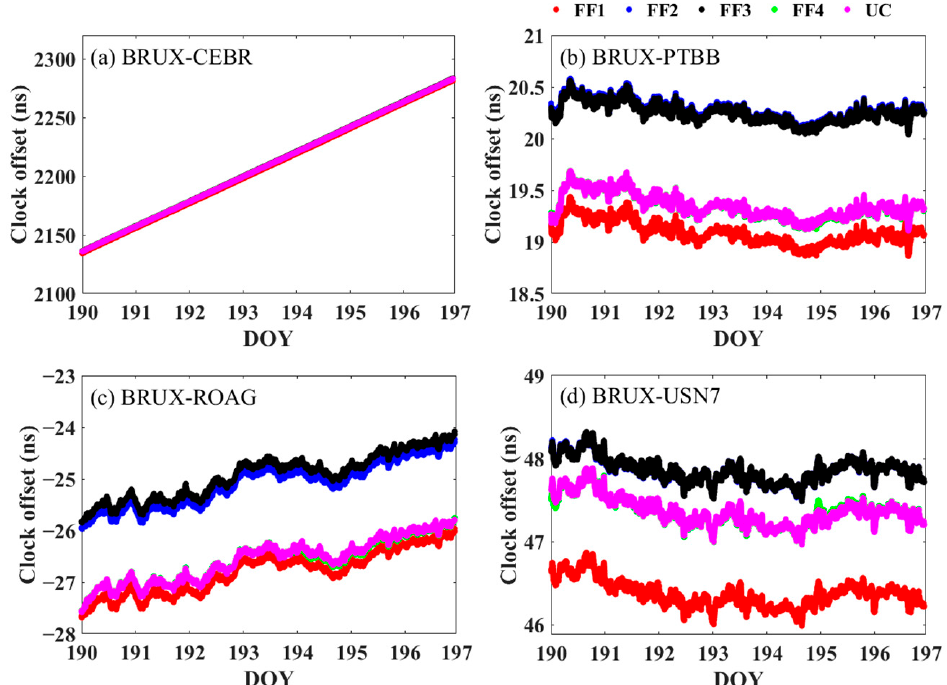
Figure 9. Clock offset sequences at four time-frequency links for the FF1, FF2, FF3, FF4 and UC PPP solutions on DOYs 190 to 196 in 2020. ( a ) BRUX-CEBR time-frequency link; ( b ) BRUX-PTBB time-frequency link; ( c ) BRUX-ROAG time-frequency link; and ( d ) BRUX-USN7 time-frequency link. Table 5. Clock offset epoch difference results at four time-frequency links for the FF1, FF2, FF3, FF4 and UC PPP models on DOYs 190 to 196 in 2020